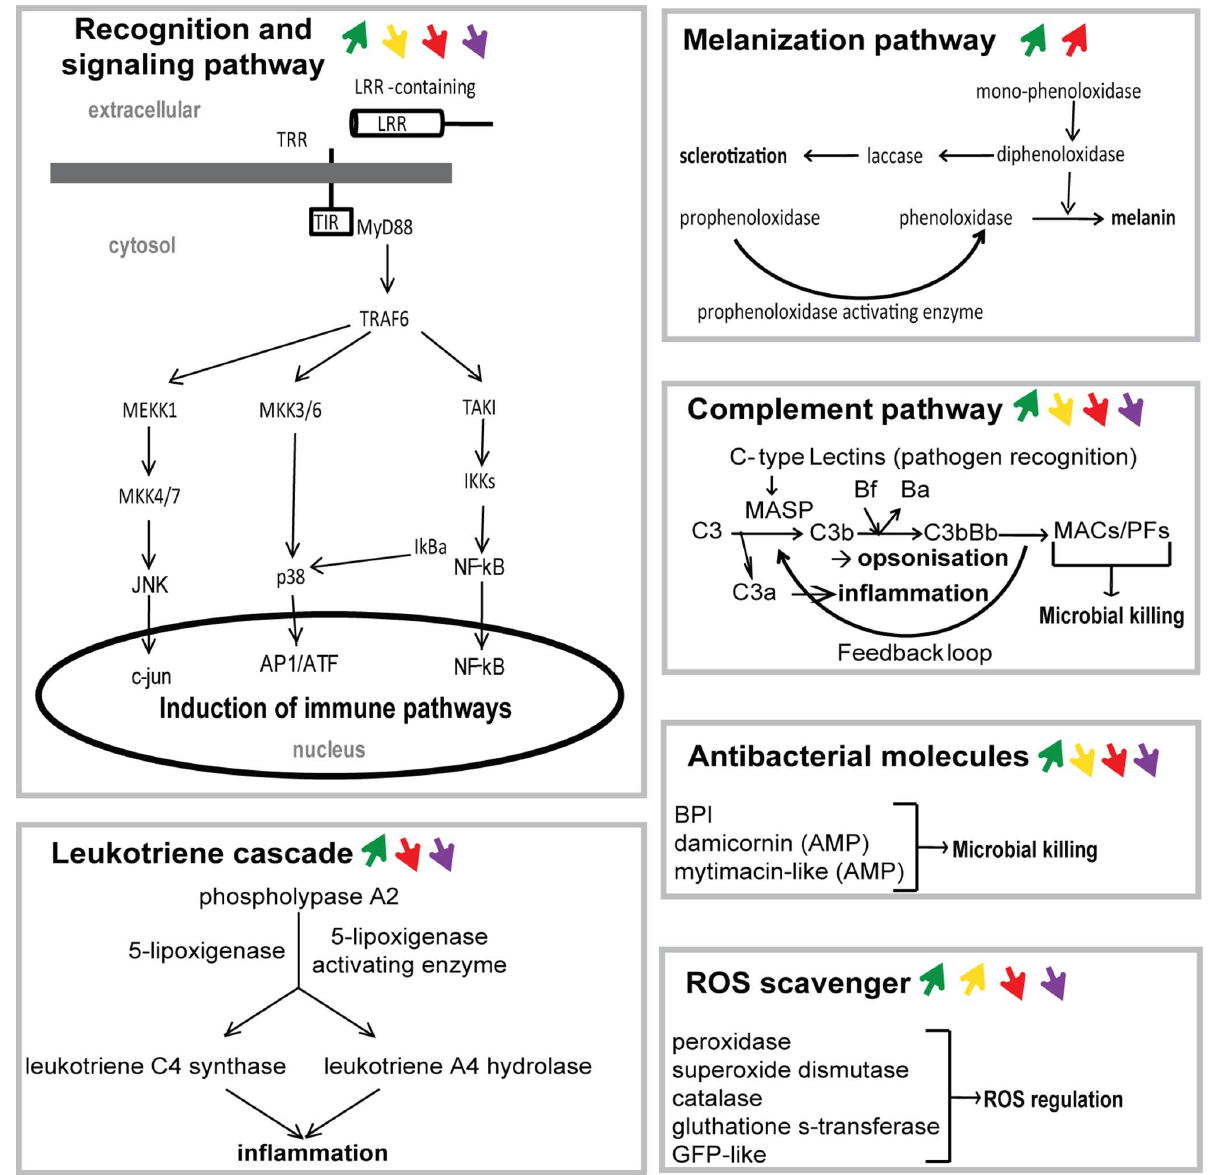
Figure 2. Expression of innate immune candidate genes. The data included q-RT-PCR results for nubbins sampled during the non-virulent, thermal stress, virulent and bacterial virulence (thermal stress vs. virulent treatment) treatments (days 3, 6, 9, 12, 15 and 18). Quantification was normalized to the control conditions for the non-virulent, thermal stress and virulent treatment, and with results for colonies sampled at the same temperature as that for the thermal stress vs. virulent comparison (bacterial virulence effect only). The results are presented as a log2-fold change in expression. The hierarchical clustering of the q-RT-PCR data was done using Multiple Array Viewer software (version 4.8.1), with average linkage clustering based on the Pearson correlation as a default distance metric. Cluster C1 represents the response to thermal stress, cluster C2 represents the response to bacteria (non-virulent and virulent), and cluster C3 represents the response to the virulence of the bacteria. The numbers at the bottom of the figure correspond to the following genes: 1, epsilon isoform 1 (housekeeping control); 2, MASP3; 3, peroxidase2; 4, peroxidase1; 5, cyclin d2 (housekeeping control); 6, preprotein translocase SecY subunit (housekeeping control); 7, laccase; 8, prophenol oxidase activating enzyme; 9, ubiquitin-conjugating enzyme E2 (housekeeping control); 10, 5-lypoxigenase; 11, catalase1; 12, nucleoredoxin; 13, TAK1; 14, MKK7; 15, MKK4; 16, JNK; 17, TRAF6; 18, IKBa; 19, NF-kB; 20, TIR2; 21, AP1; 22, ATF; 23, Bf; 24, C3; 25, MASP1; 26, catalase2; 27, MKK3/6; 28, IKK; 29, p38; 30, LRR2; 31, apextrin; 32, SOD1; 33, leukotriene A4 hydrolase; 34,Leukotriene C4 synthase; 35, MyD88; 36, GFP-Like2; 37, TIR3; 38, SOD2; 39, MEKK1; 40, LPBPI; 41, LRR-TIR-IGG; 42, GFP-Like1; 43, Tx60A2; 44, Tx60A1; 45, PdC-Lectin; 46,damicornin; 47, phospholipase A2; 48, mytimacin-like.